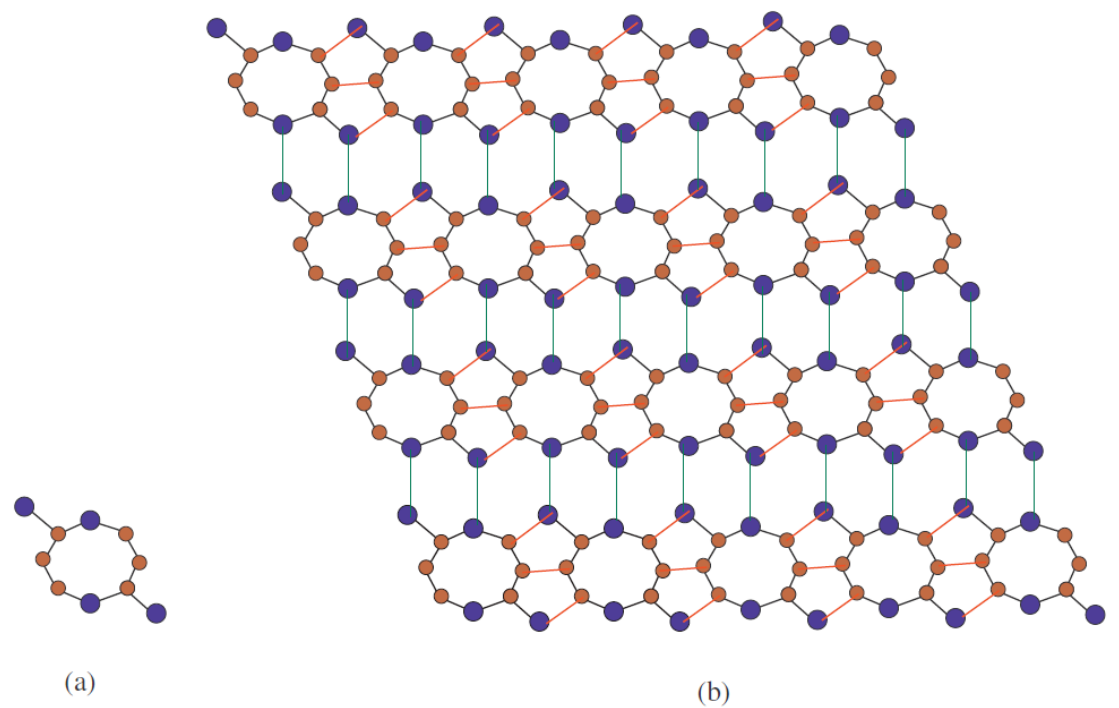
C - III [ n , m ] 2 3 C - III [ n , m ], 2 3